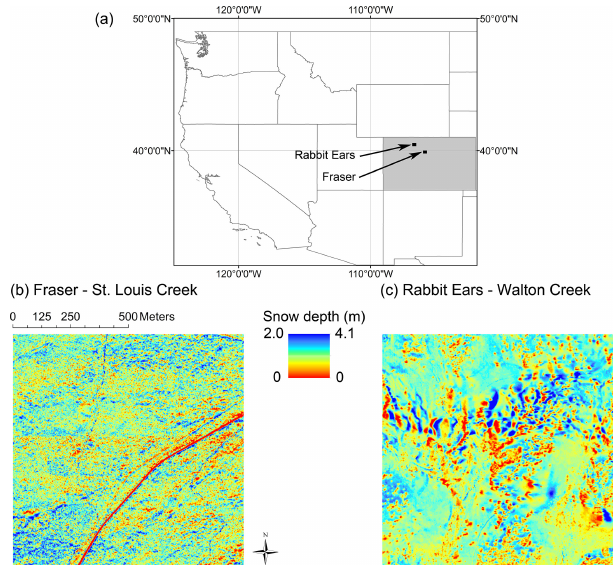
Figure 1. (a) Location of the Fraser and Rabbit Ears study areas in the state of Colorado. (b) LIDAR Snow depth distributions on 8 April 2003, at the Saint Louis Creek intensive study area (ISA) and (c) on 9 April at the Rabbit Ears